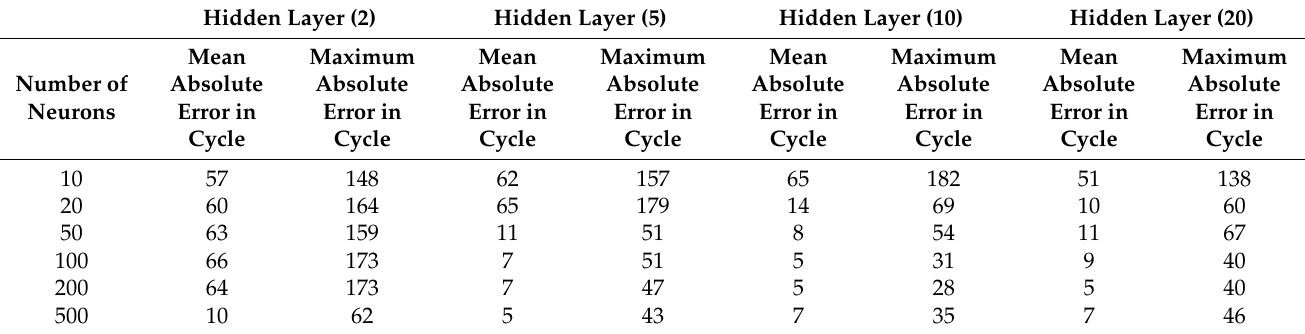
Table 8. Comparison results of FEM and ANN models on 576 training datasets.